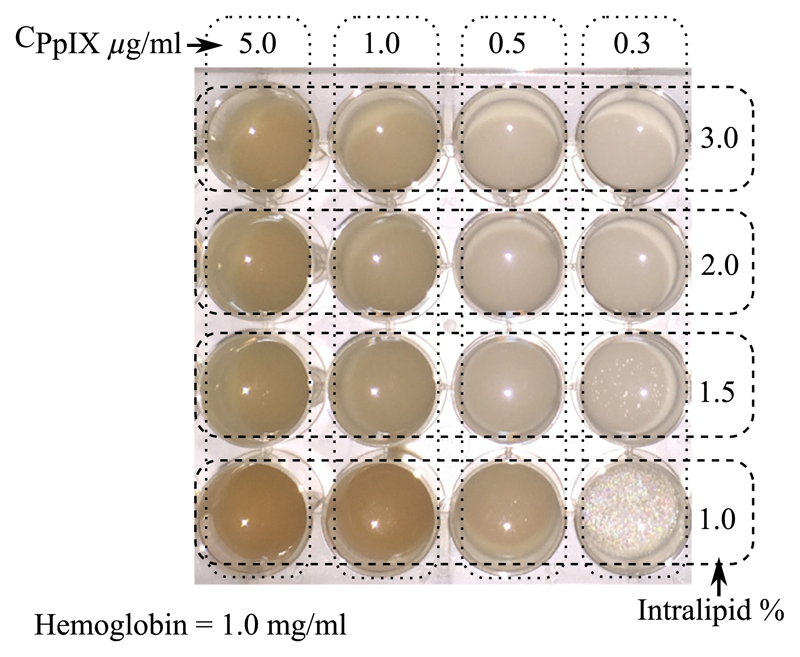
A photograph of phantom set B illustrates that the shade of each phantom in the well varies with the concentration of the PpIX and IL collaterally.